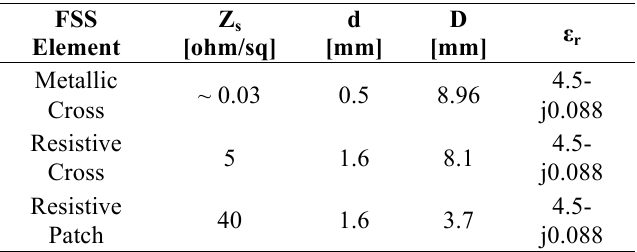
Figure 4 - Reflection coefficient of wideband 1-layer, 2layers and 3-layers HIS absorbers. The 1-layer and 2-layers structures are synthesized by employing resonant FSS elements. The 3-layers and 4-layers structures have been presented in [27]. Table 1: Electrical and geometrical parameters of the analyzed absorbing ultra-narrowband and narrowband